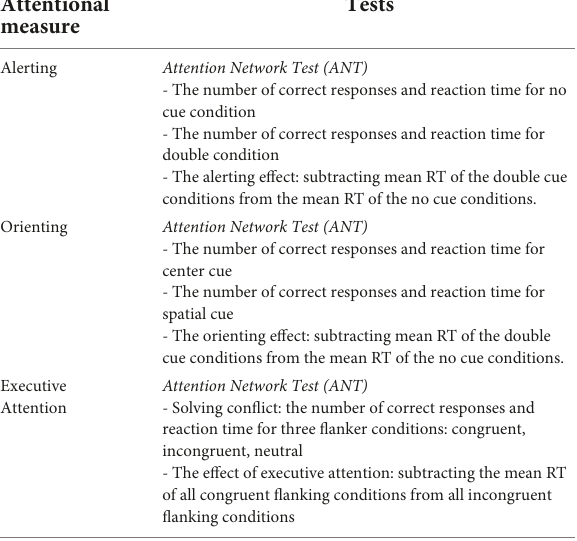
Kahneman (36), in which trials below 200 ms and above 1,500 ms were